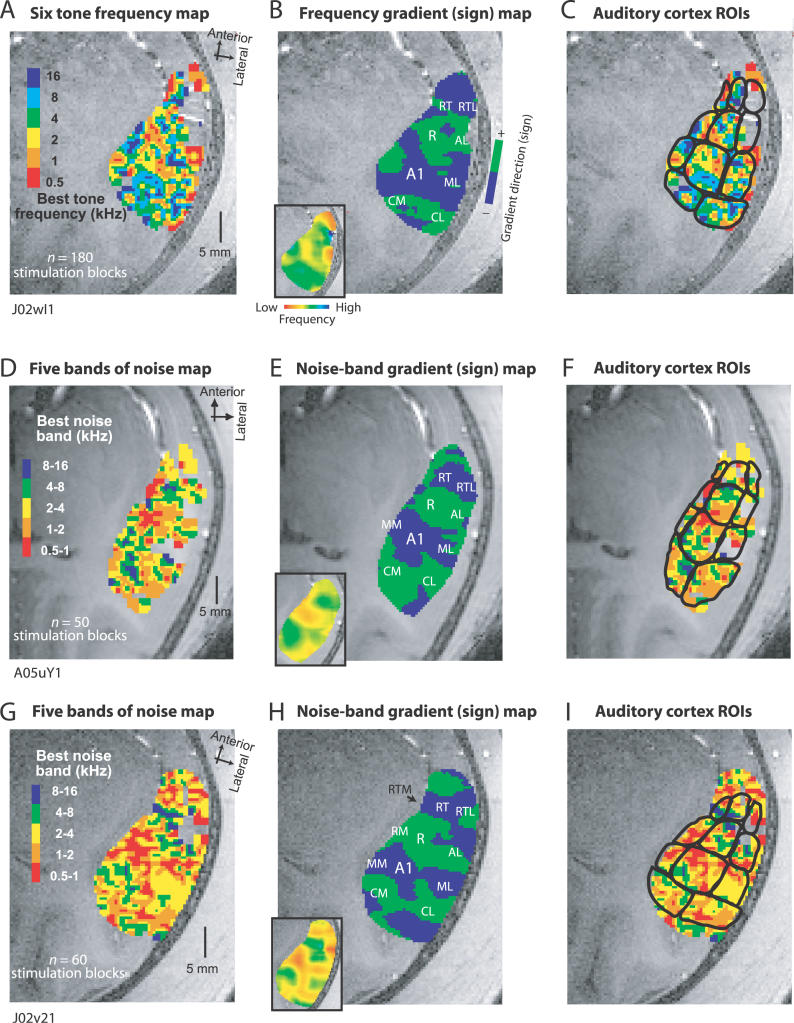
Delineating ACF Borders with Multiple Tones and Bands of Noise(A–C) An additional multi-tone experiment with animal J02. Format as for
Figure 5 (A), (C and D). (D–I) Show the results from two animals where five one-octave bands of noise (band-passed noise) were used to localize ACFs. (D and G) Five best noise-band maps showing the antero-posterior frequency gradients. (E and H) show the gradient sign procedure revealing borders between neighboring ACFs. (C, F, and I) show auditory cortex ROI outlines. The results of the gradient tests within these outlines in comparison to the model gradient are shown in
Table 1.